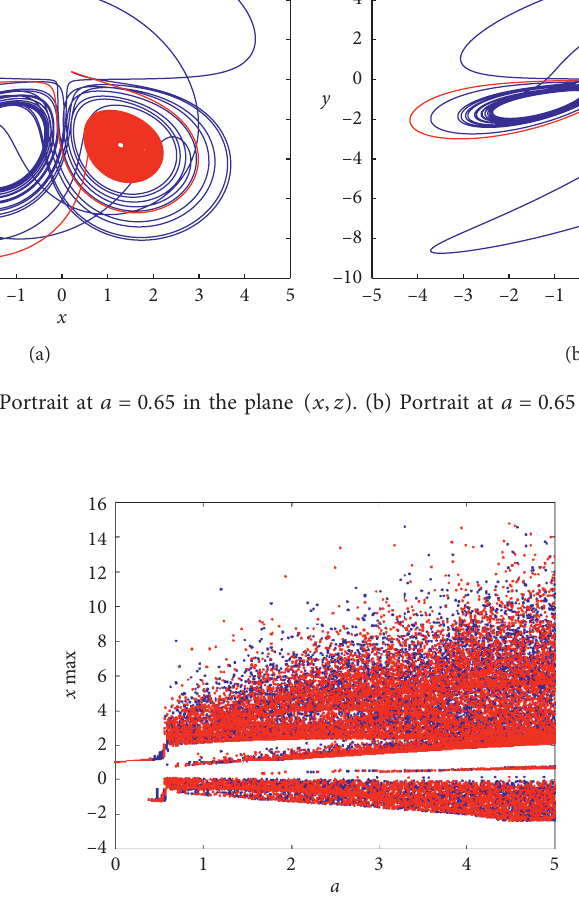
Figure 25: Bifurcation diagram versus the parameter a at ( 0 . 2 , 0 . 2 , 0 . 2 ) and ( 0 . 5 , 0 . 2 , 0 . 2 )